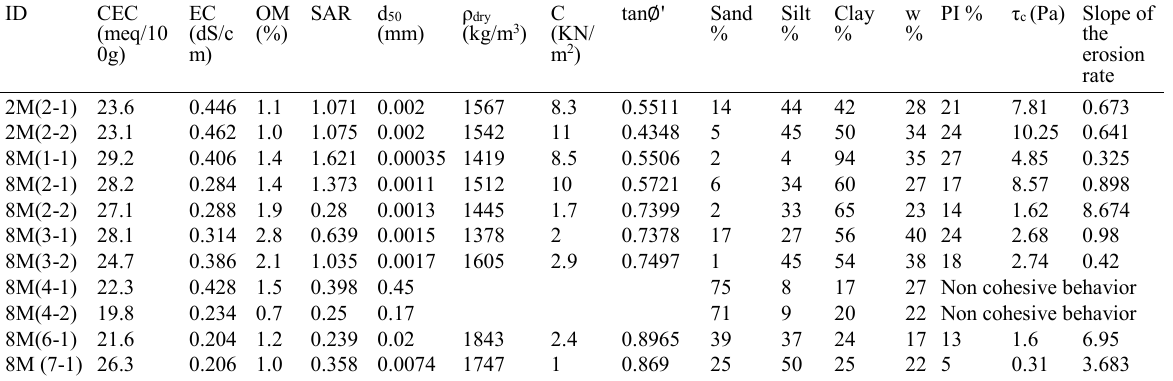
Fig. 5 Sample 8M (2-2) with the highest (M) value. Table 1 Physical properties of soil